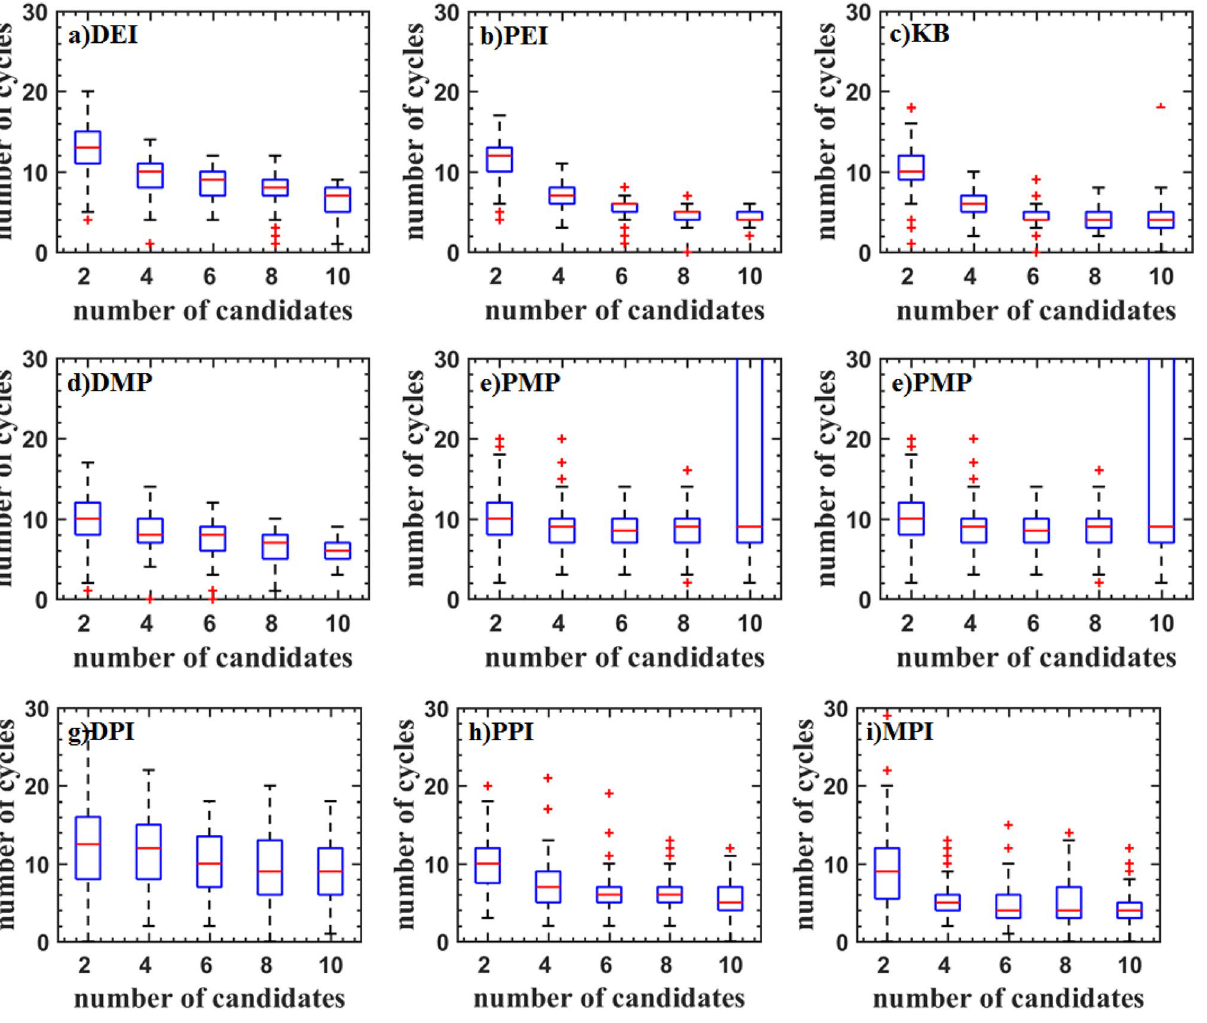
Figure 6. Test problems: Sasena